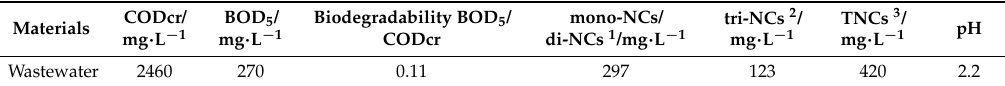
Table 3. Characteristics of nitrobenzene compounds